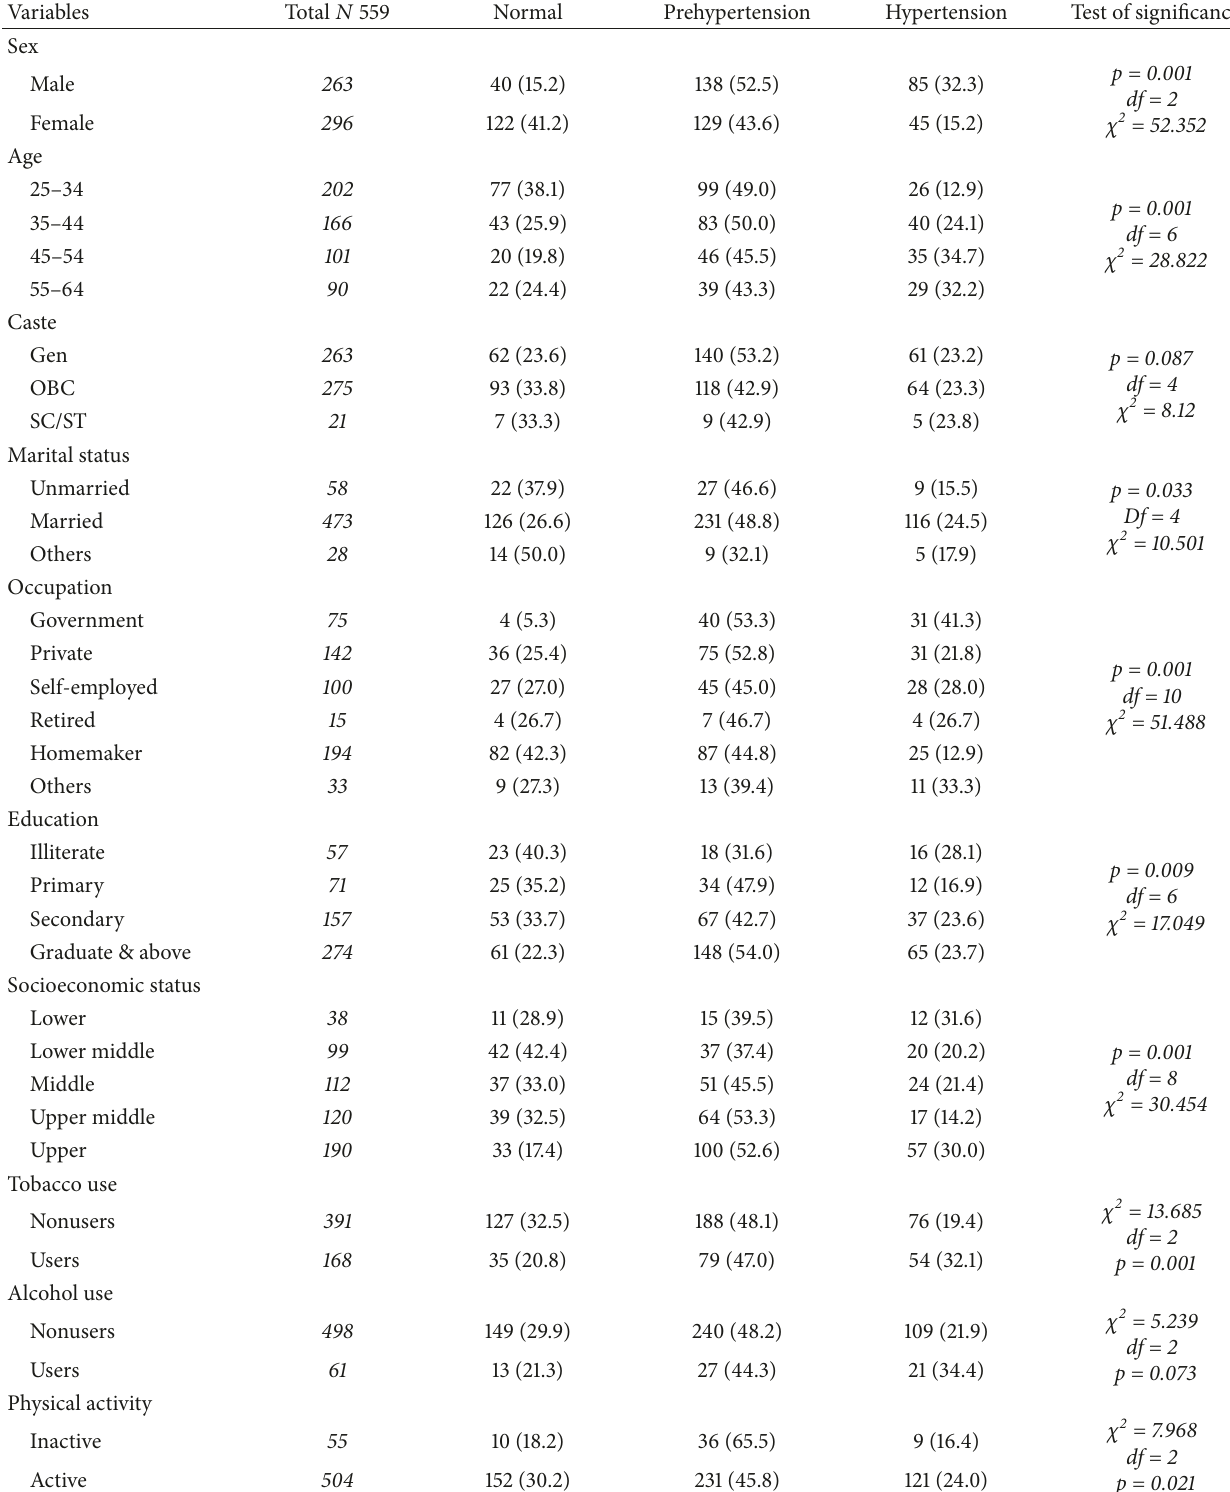
Table 5: Prevalence of prehypertension and hypertension ∗ according to sociodemographic characteristics and behavioral risk